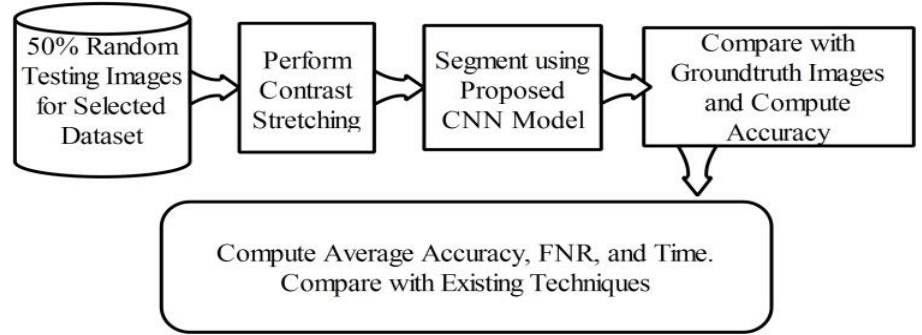
Figure 16. Flow diagram of testing lesion segmentation accuracy using the proposed scheme.